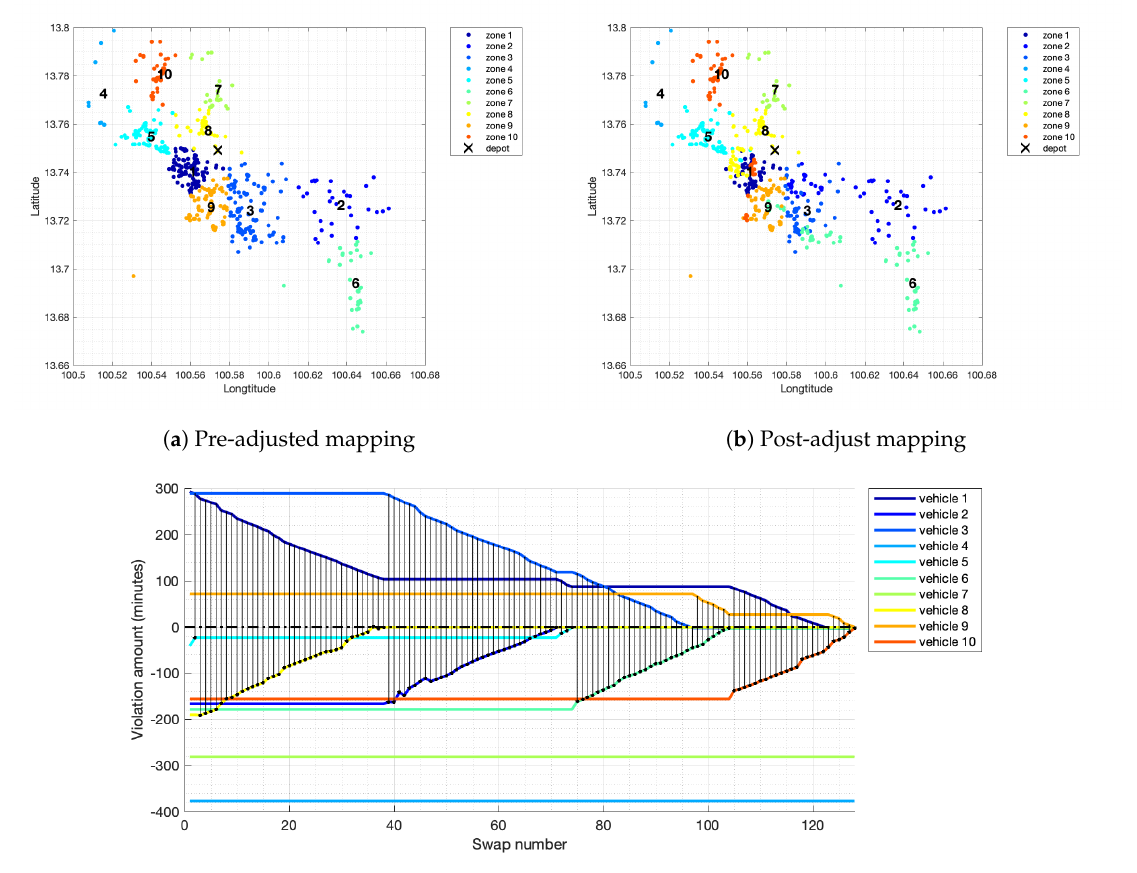
Figure 1. Didactic example: ( a ) pre-adjusted mapping; ( b ) post-adjusted mapping; ( c ) the adjusted working time violation of each vehicle as a function of the swap